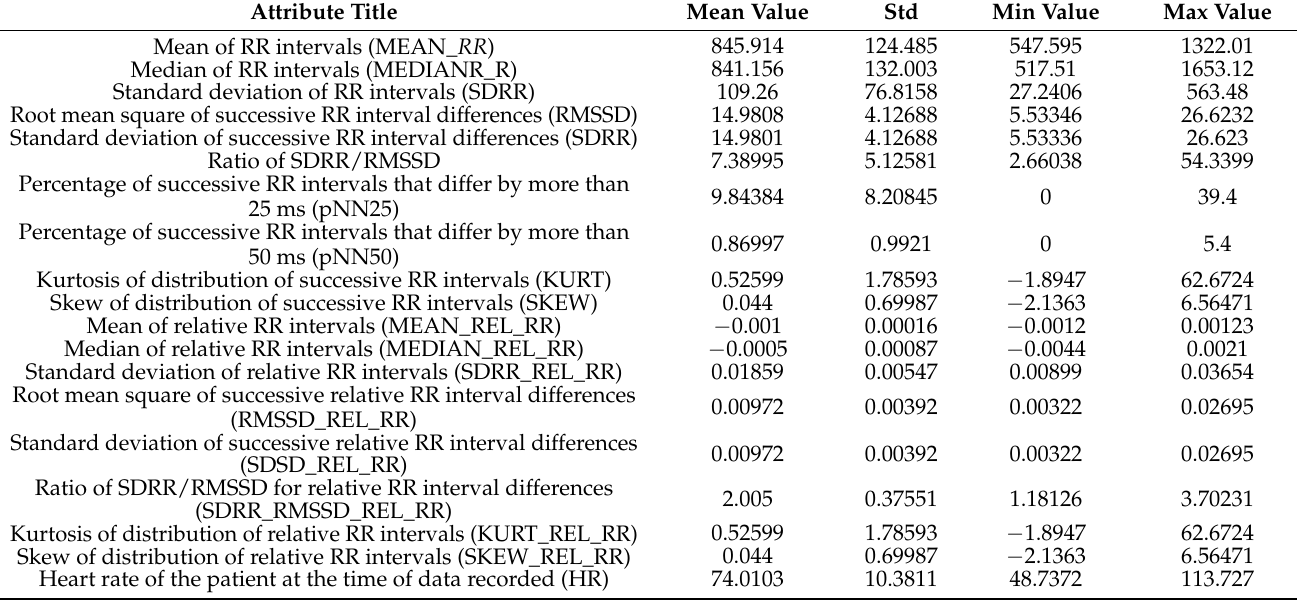
Table 1. The main characteristics of the